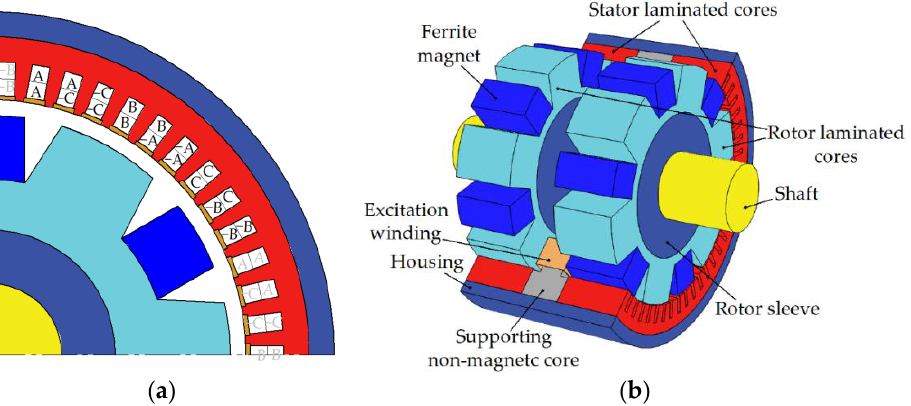
Figure 1. SHG approximate geometry: ( a ) Cross-section and stator armature winding configuration (1/4 of the generator cross-section is shown, the other parts are symmetrical); ( b ) General view. One half of a stator cutout is shown. Rotor is shown without cutout. The armature winding placed in the stator slots is not shown.